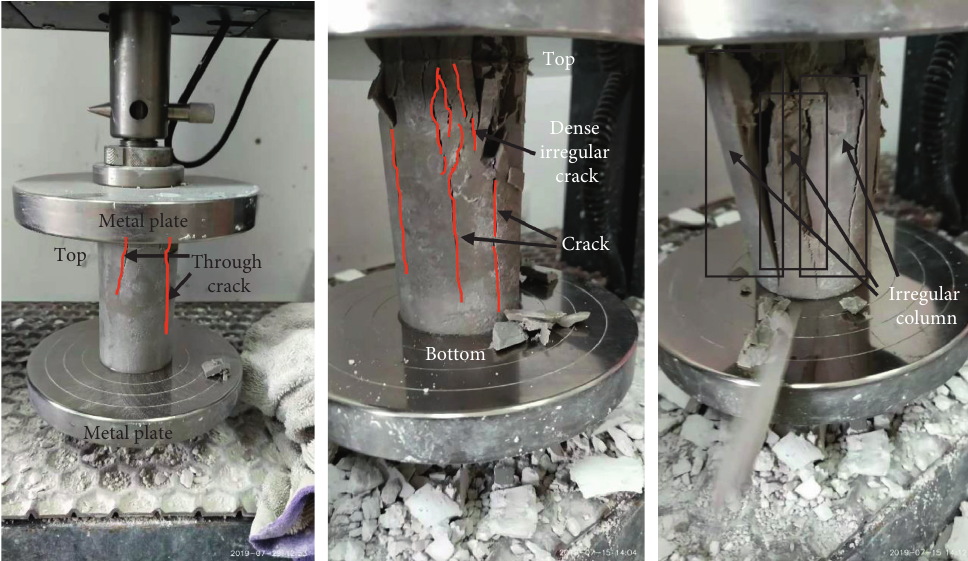
Figure 8: Fracture morphology of the cylindrical specimen under